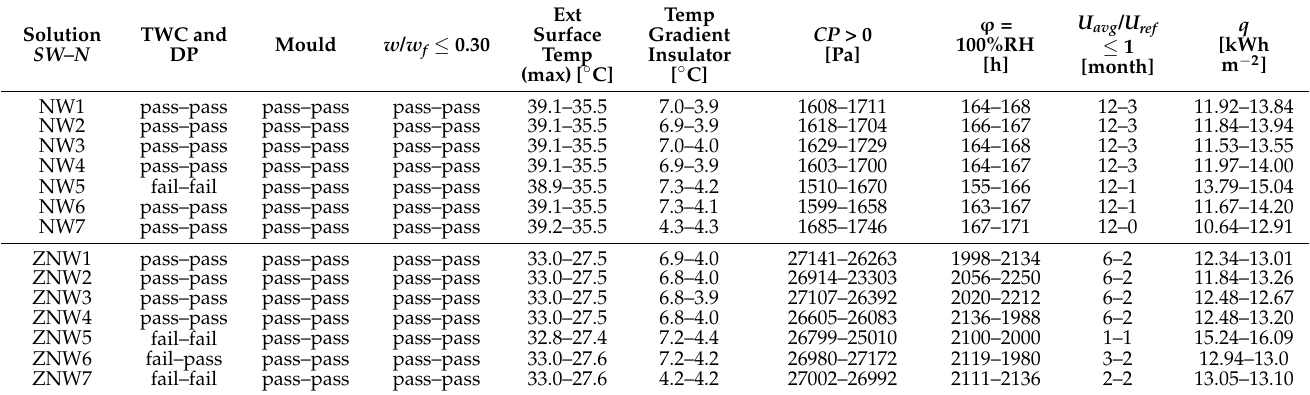
Table 7. Synthesis of the new wall simulations for Lisbon (NW) and Zurich